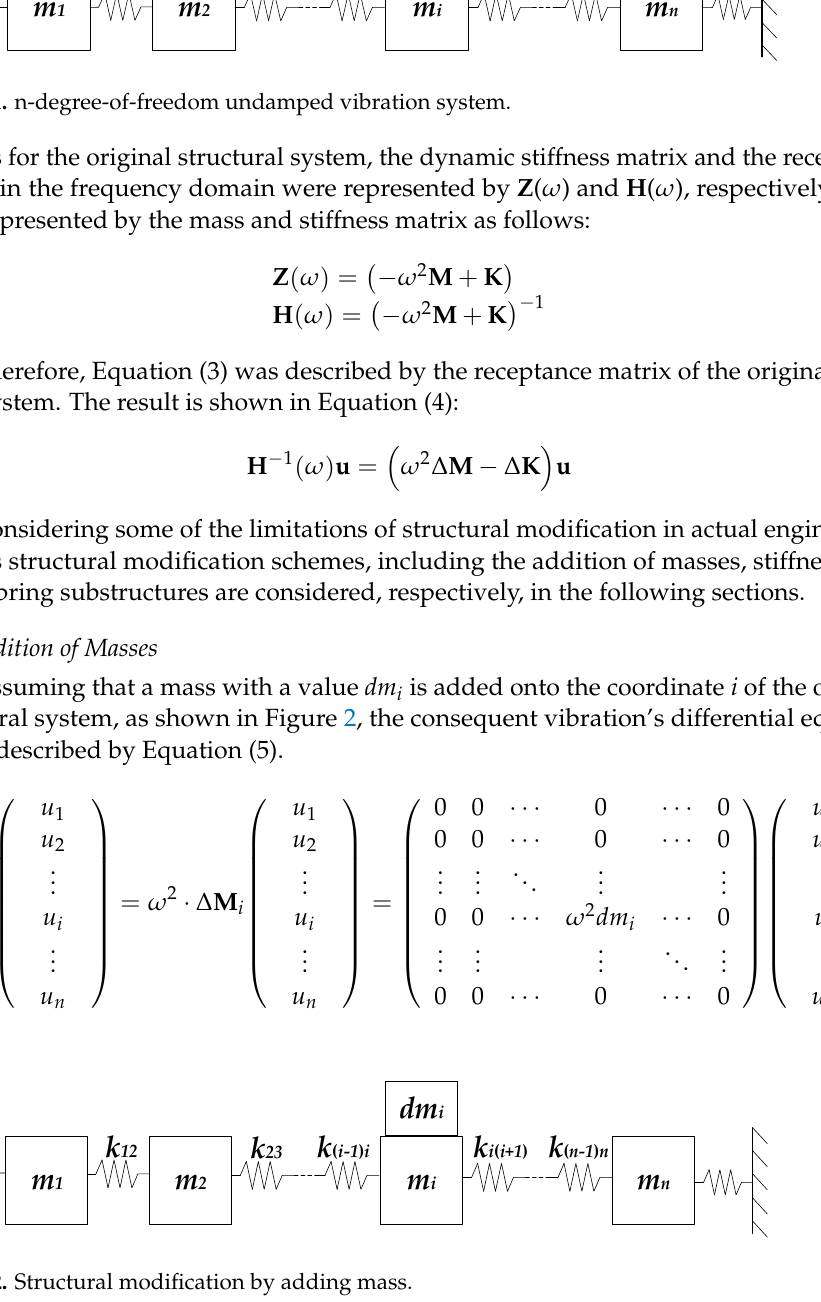
Figure 2. Structural modification by adding mass.